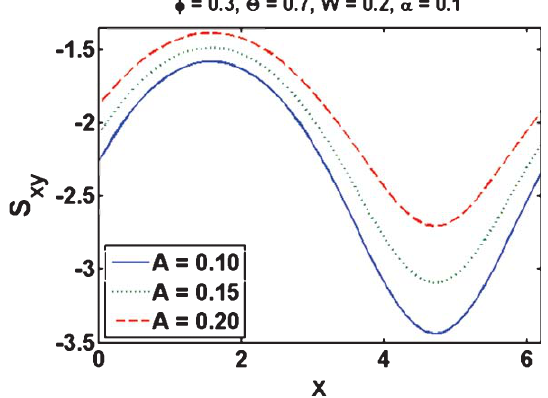
Fig. 5. Variation in shear stress ( S xy ) against y for different values of slip parameter ( α ).